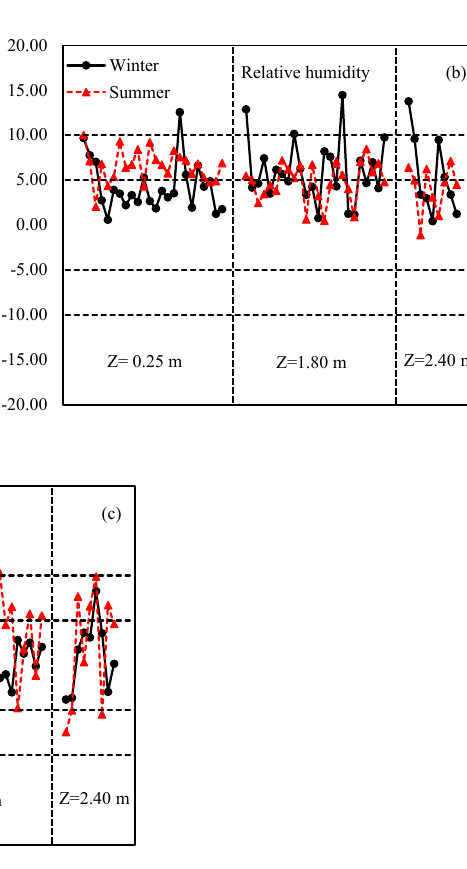
Figure 3. Relative errors of ( a ) temperature, ( b ) relative humidity, and ( c ) airspeed in summer and winter.